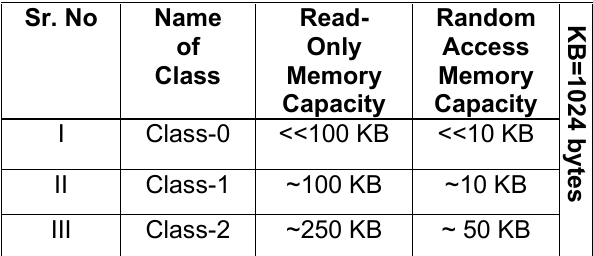
Table 1. Characterization of Constrained IoT Gadgets for the Benefit of their Framework Assets Sr. No